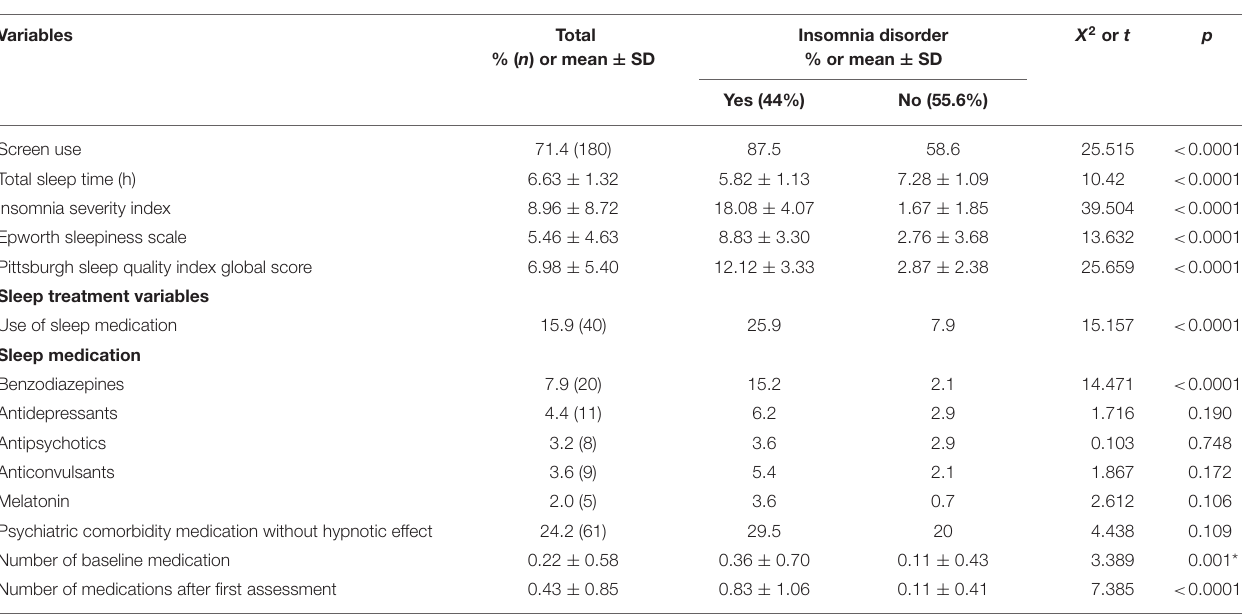
TABLE 3 | Sleep variables related to insomnia